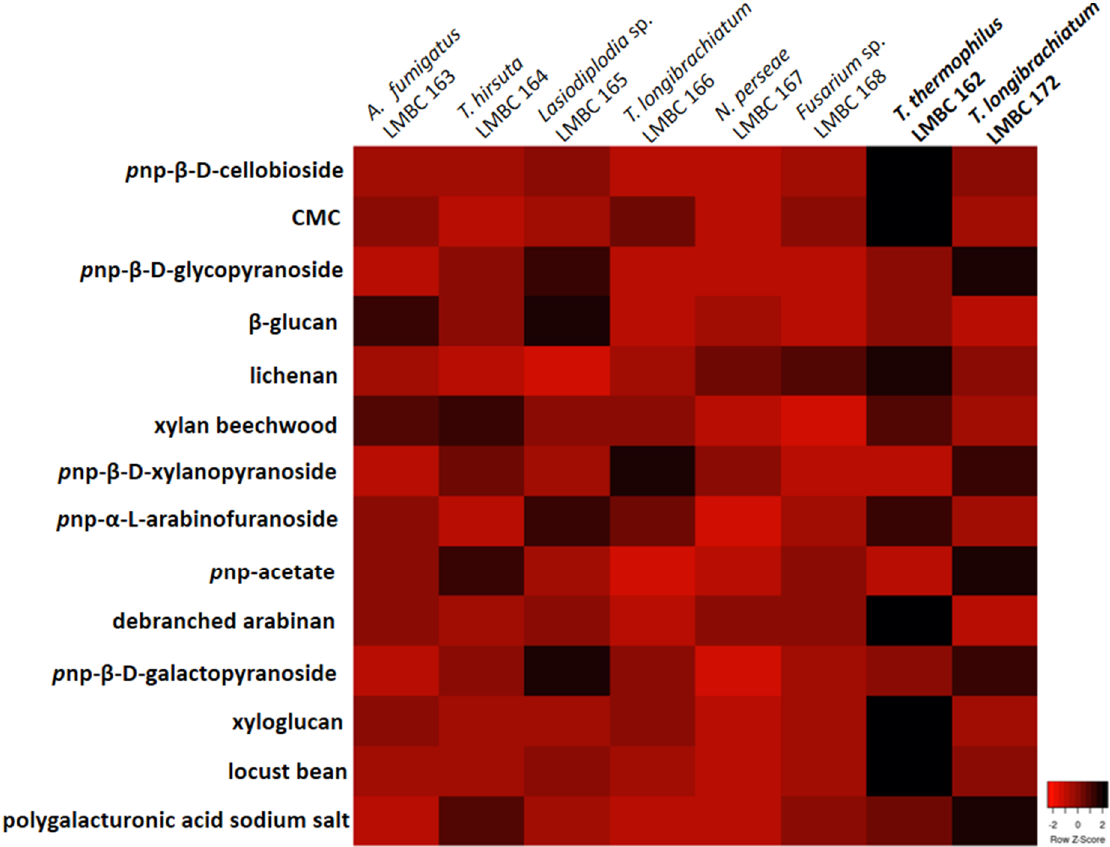
Figure 2. Heatmap regarding the eight isolates and the fourteen produced enzymes with their substrates.